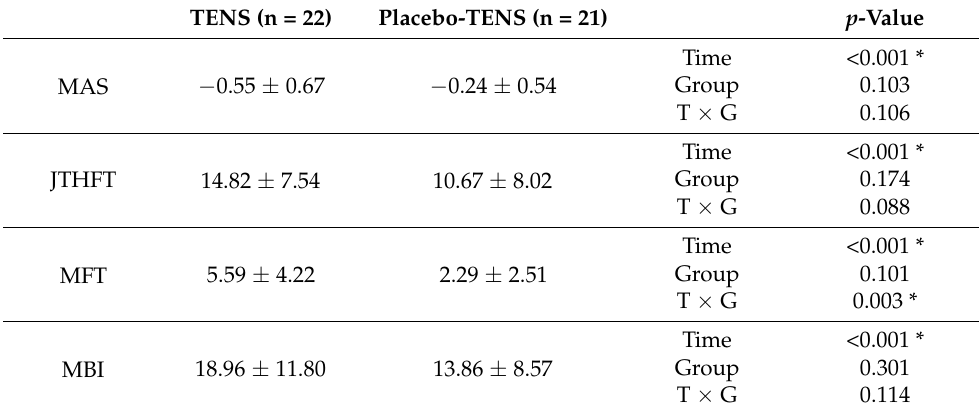
T × G 0.114 Values are expressed as mean ± SD for post values–pre values. Abbreviations—TENS: transcutaneous electrical nerve stimulation; MAS: Modified Ashworth Scale; JTHFT: Jebsen–Taylor Hand Function Test; MFT: Manual